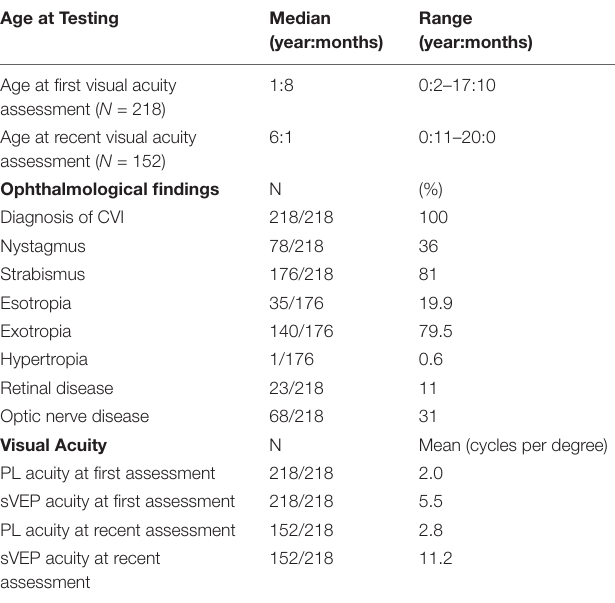
TABLE 2 | Ophthalmological characterization of CVI